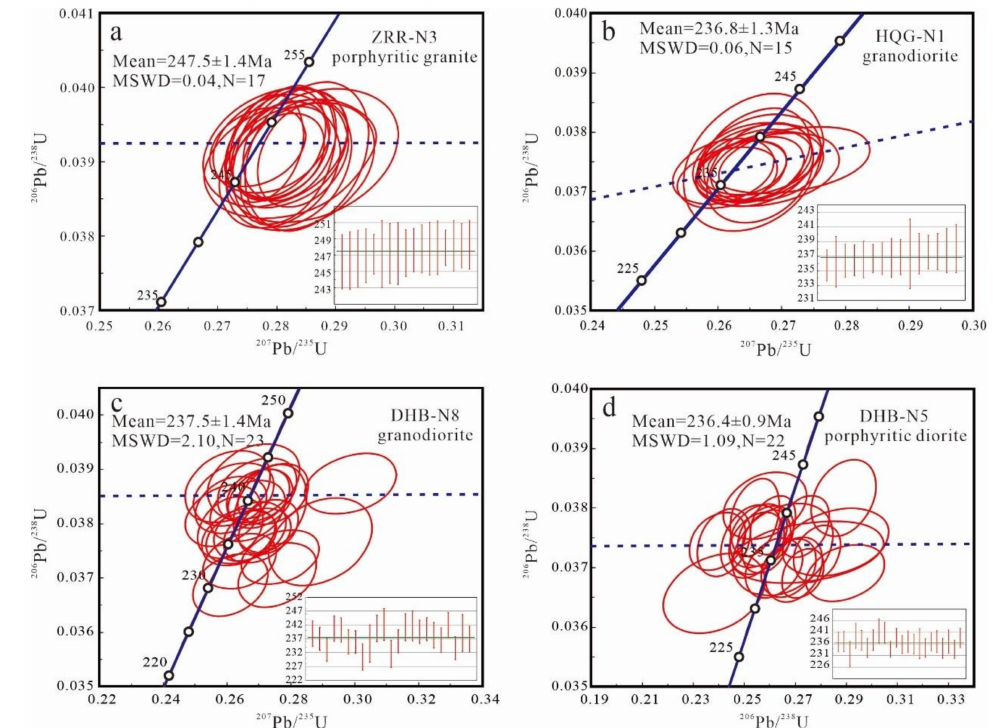
Figure 5. The zircon LA-ICP-MS U-Pb concordia diagrams for the intermediate-acid intrusive rocks in the Ela Mountain area. Weighted-mean ages are shown in each panel. ( a ) The zircon LA-ICP- MS U-Pb concordia diagrams and weighted-mean ages for ZRR-N3 (porphyritic granite). ( b ) The zircon LA-ICP-MS U-Pb concordia diagrams and weighted-mean ages for HQG-N1 (granodiorite). ( c ) The zircon LA-ICP-MS U-Pb concordia diagrams and weighted-mean ages for DHB-N8 (granodi- orte). ( d ) The zircon LA-ICP-MS U-Pb concordia diagrams and weighted-mean ages for DHB-N5 (porphyritic